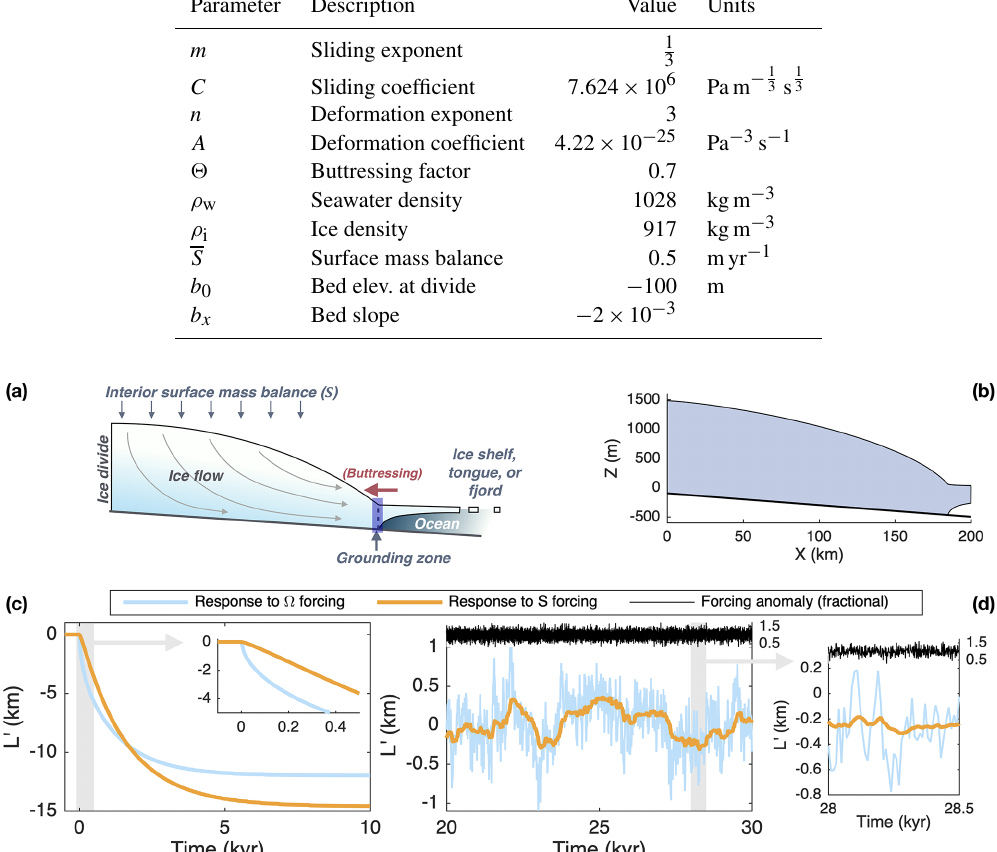
Figure 1. Model schematic and responses to ocean forcing (via (cid:127) ) and interior forcing (via S ). (a) An idealized marine-terminating glacier system. (b) Initial steady-state profile simulated by the flowline model. (c) Length responses to 20% step increase in (cid:127) (blue) and 20% step decrease in S (orange) at t = 0. Inset panel zooms into the first 0 . 5kyr of response. Note the difference in initial retreat rates depending on the type of forcing. (d) Length responses to white-noise interannual variability in (cid:127) or S . Right panel shows a 0 . 5kyr segment in more detail. Anomalies (black) have a standard deviation of 20% of the mean value and have opposite signs for (cid:127) and S so that length anomalies are correlated for comparison. The response to ocean forcing (blue) contains much more high-frequency content than the response to interior forcing